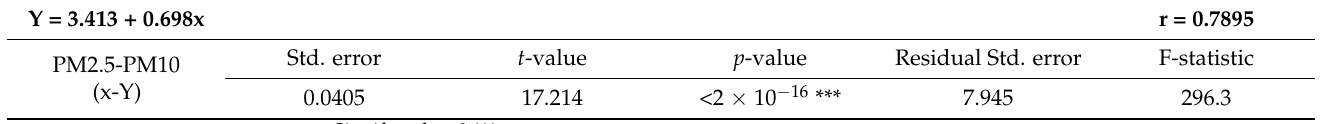
Table 1. Summary statistics from linear regression model for PM2.5 and PM10.